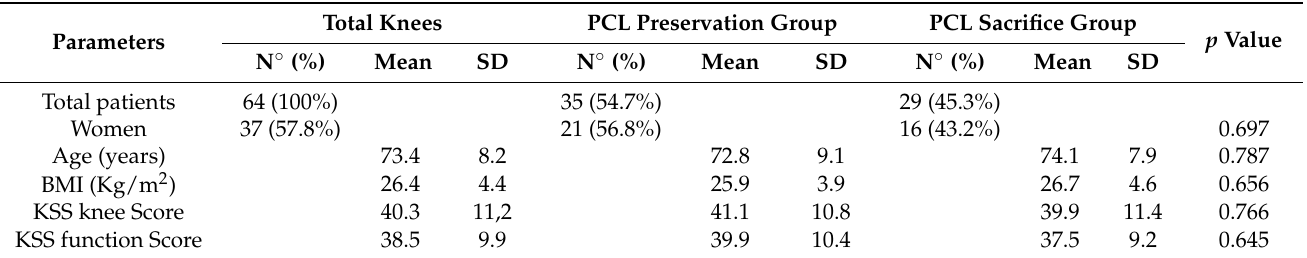
Table 1. Preoperative demographic and clinical data of patients undergoing KA MP-TKA with or without PCL preservation.